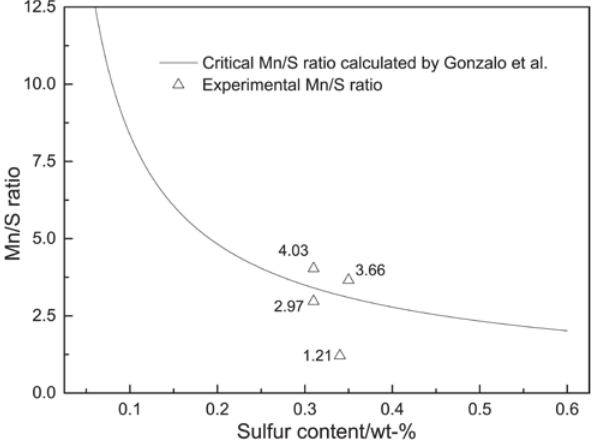
Fig. 2: A comparison between the experimental Mn/S ratio in this work and the theoretically deduced critical Mn/S ratio by Gonzalo and Oscar et al.